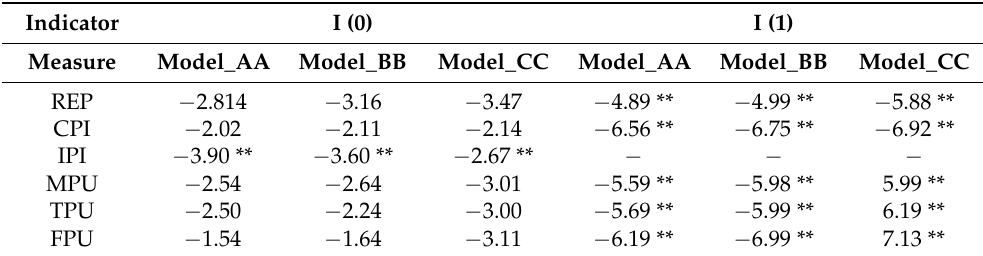
Table 3. SOR Test.